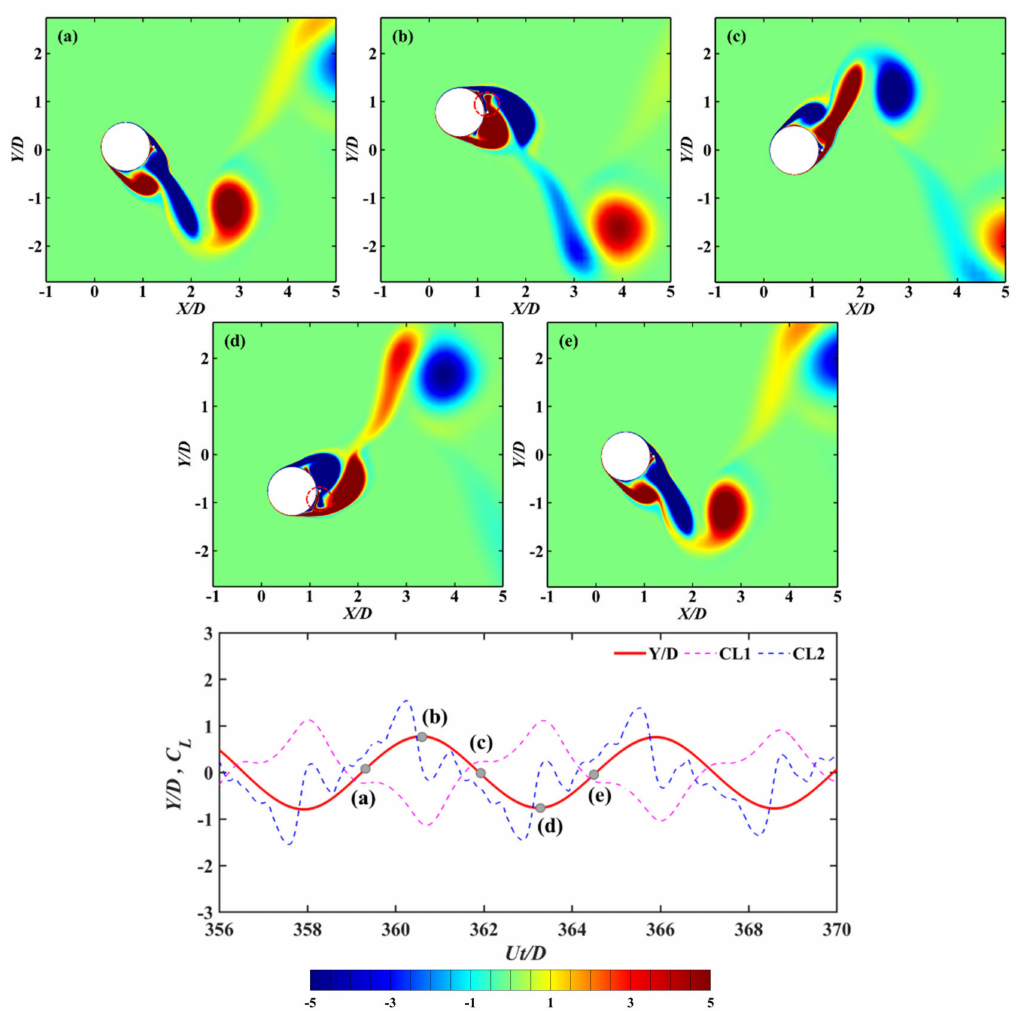
Figure 17. Instantaneous vorticity contours for the typical time instants in one vibration period at d/D = 0.05, α = 0 ◦ , and U r = 6: ( a ) Ut/D = 359.3; ( b ) Ut/D = 360.6; ( c ) Ut/D = 361.9; ( d ) Ut/D = 363.2; ( e ) Ut/D =